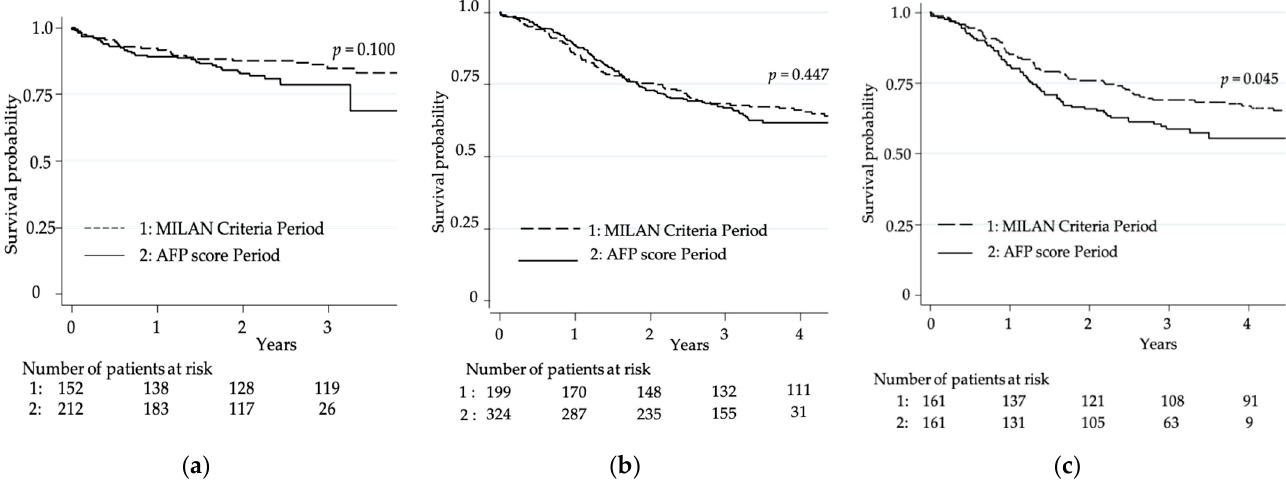
Figure 3. Overall survival. ( a ) Post-transplant overall probabilities of survival in MilanCP and AFPscP; ( b , c ) Post-listing overall probabilities of survival in MilanCP and AFPscP ( b ) without propensity matching and ( c ) with propensity score matching.